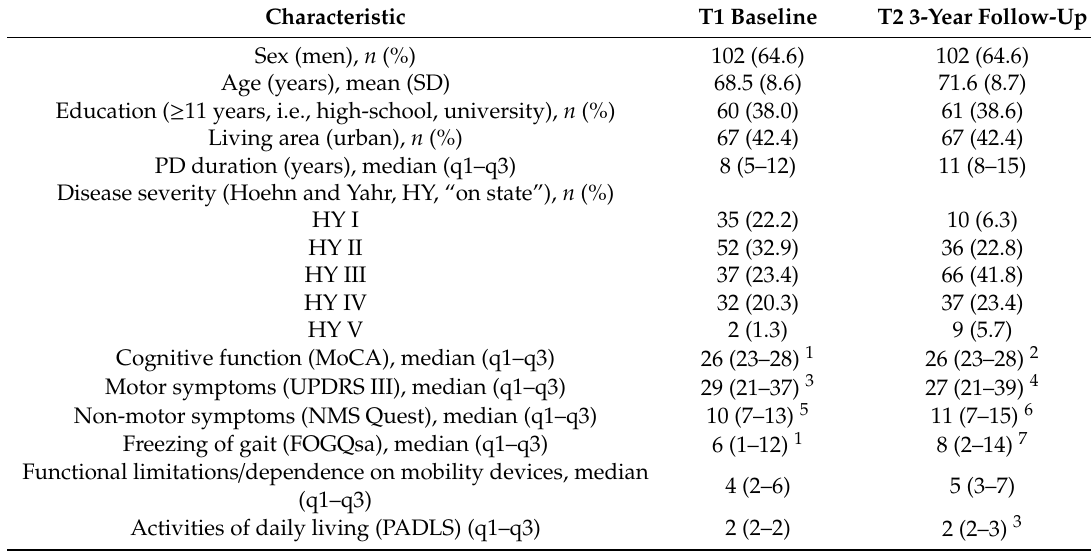
Table 1. Descriptive information and participant characteristics at baseline (T1) and 3-year follow-up (T2), sample size N =